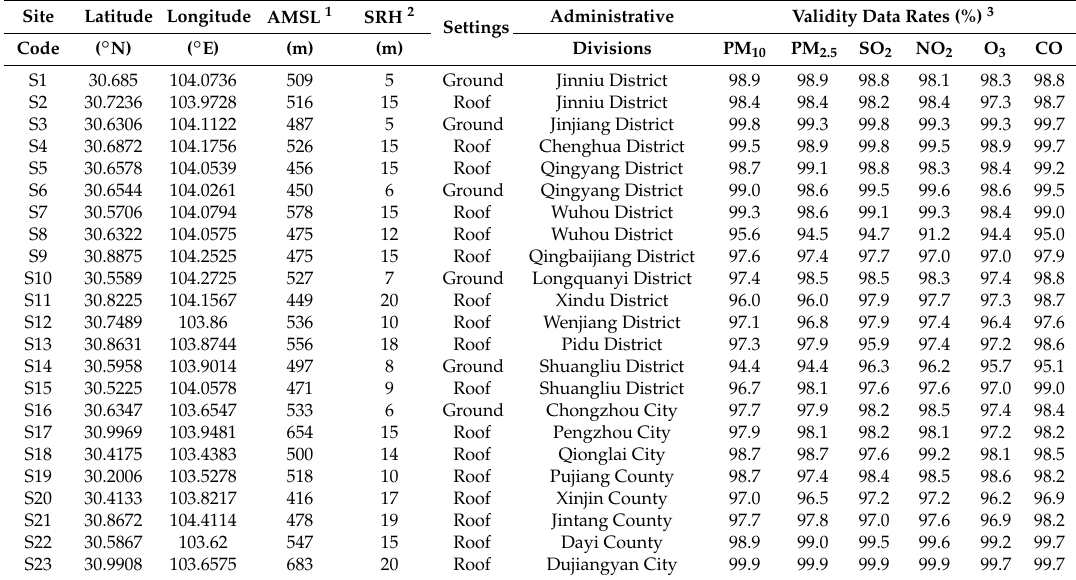
Table 1. Basic details of the 23 ambient air automatic monitoring stations in Chengdu. Site Latitude Longitude AMSL 1 SRH 2 Administrative Validity Data Rates (%) Settings